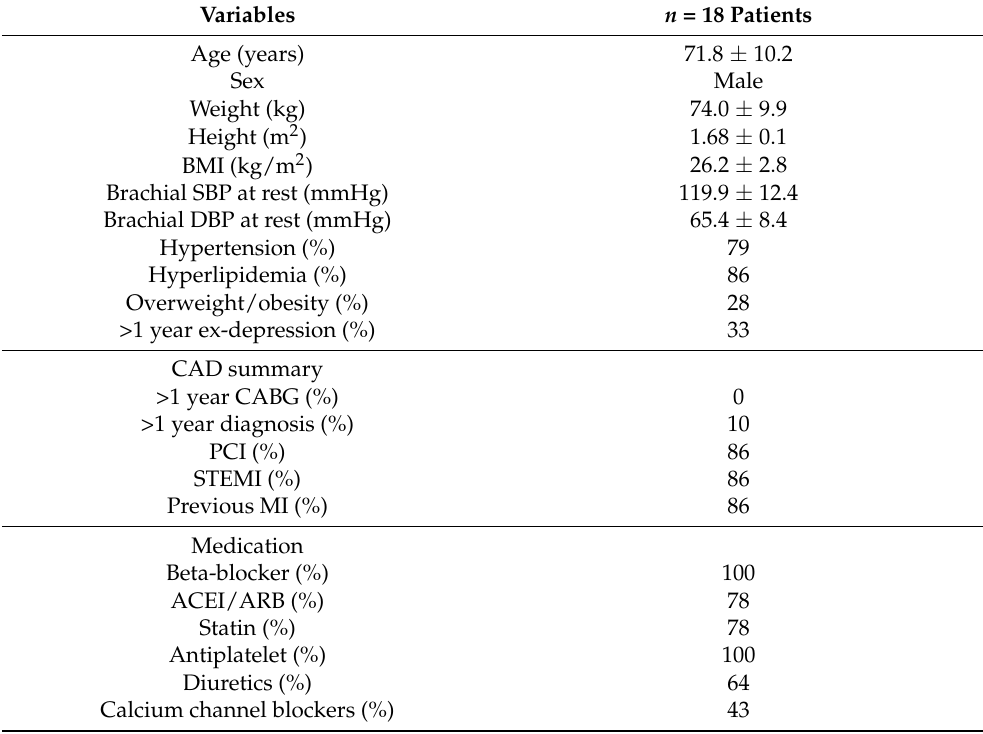
Table 1. Characteristics of the